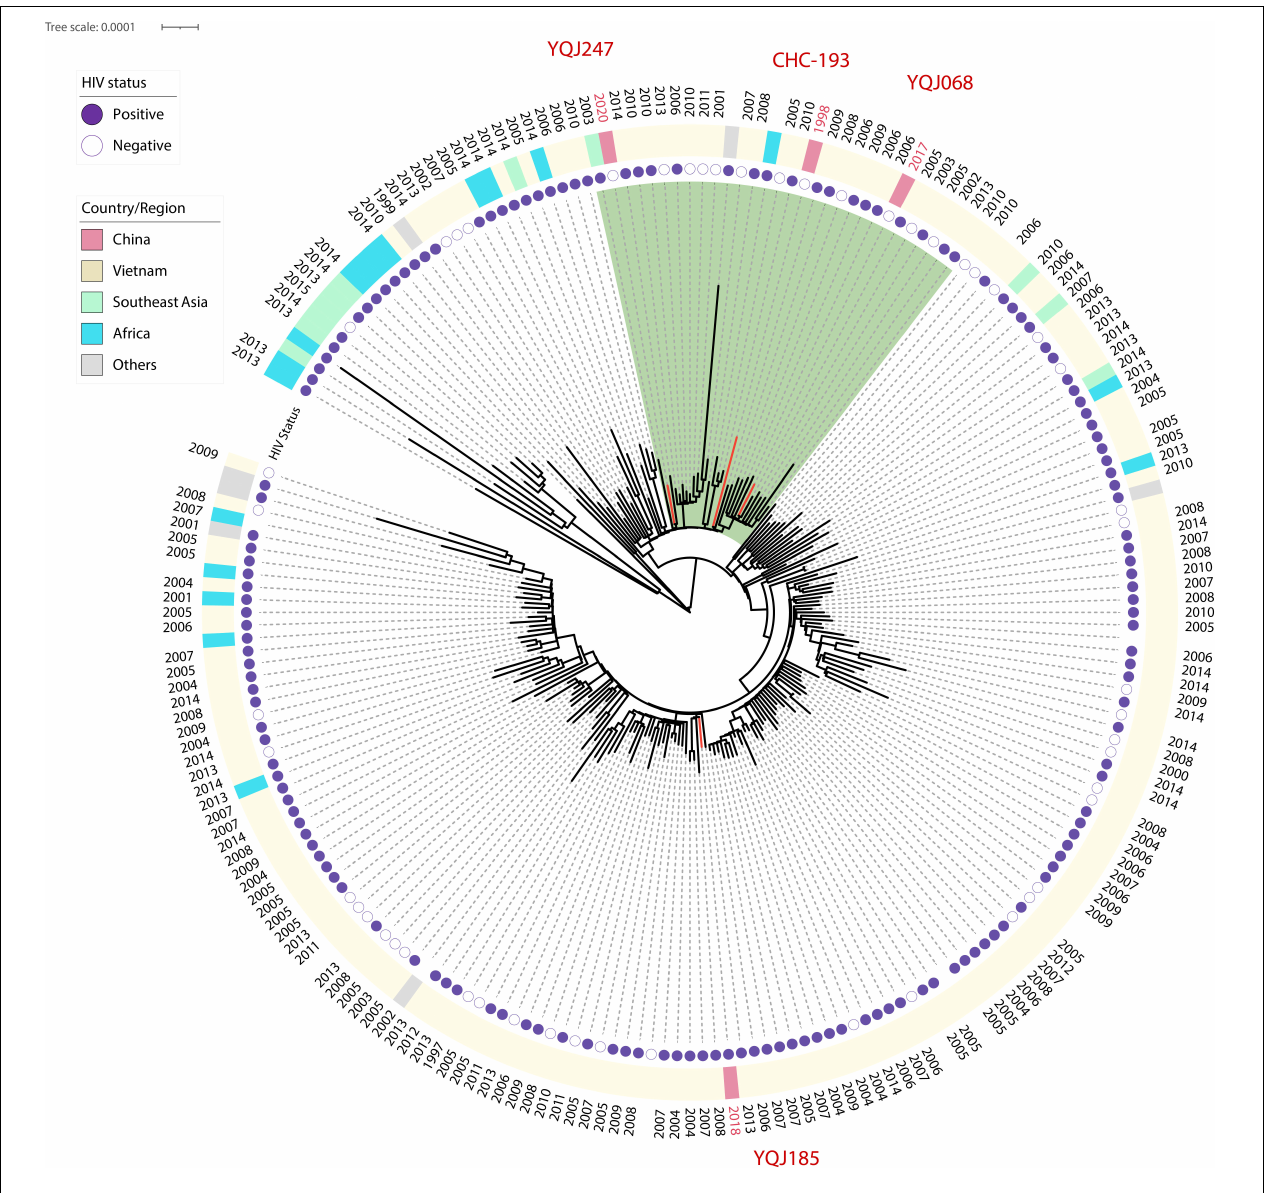
FIGURE 3 | Core SNP phylogenetic tree of global ST5 C. neoformans . H99 reference was used as reference and outgroup; 44,487 SNP sites were used to generate this tree. Red branches represent isolates from